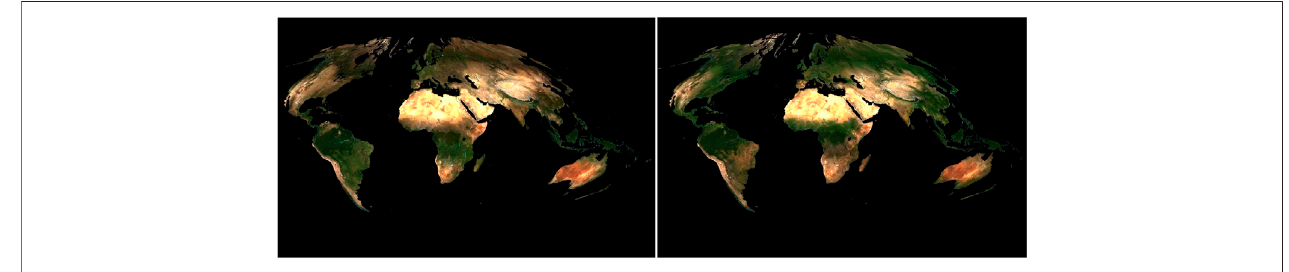
FIGURE 3 | The monthly average RGB surface BRDF for February (left) and July (right) of 2016 from MAIAC MODIS MCD19A3 product.